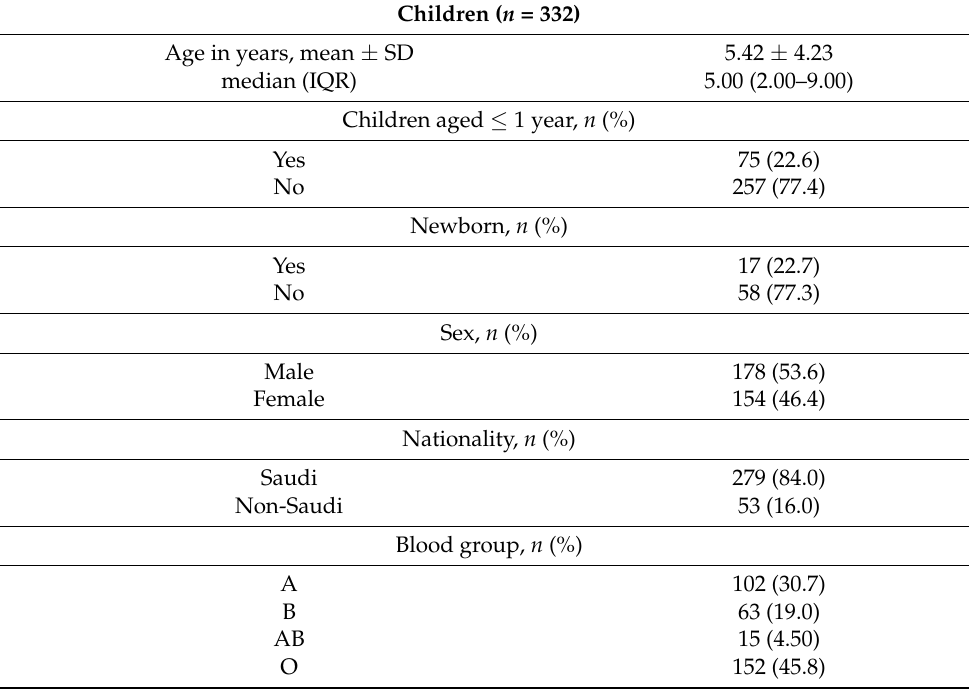
Table 1. Characteristics of the study participants ( n =